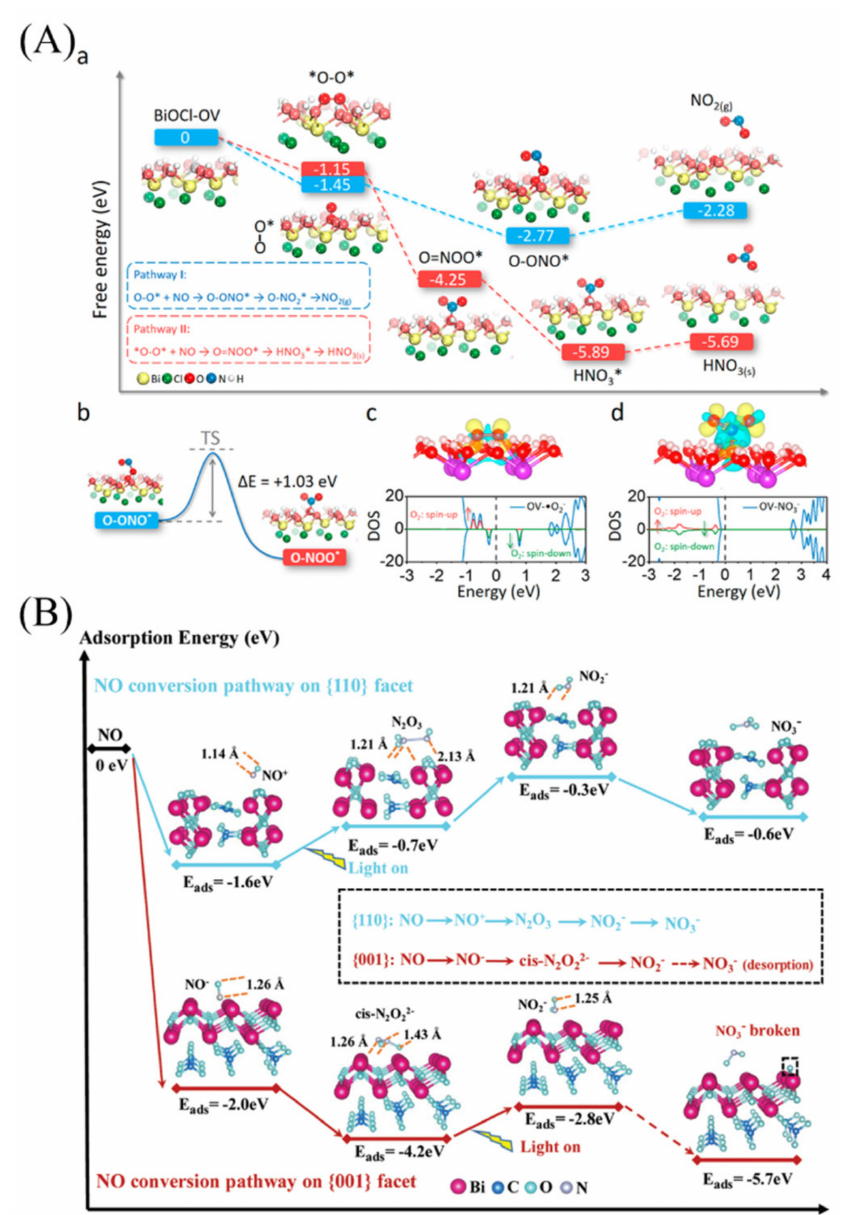
Figure 5. ( A ) Free energy change versus reaction coordinates for the oxidation of NO by • O 2 − on BiOCl(001) surface in different geometries. Reprinted with permission from reference [128]. ( B ) Adsorption energy and bond length of several major intermediate adsorption products on 110-BOC and 001-BOC. Reprinted with permission from reference